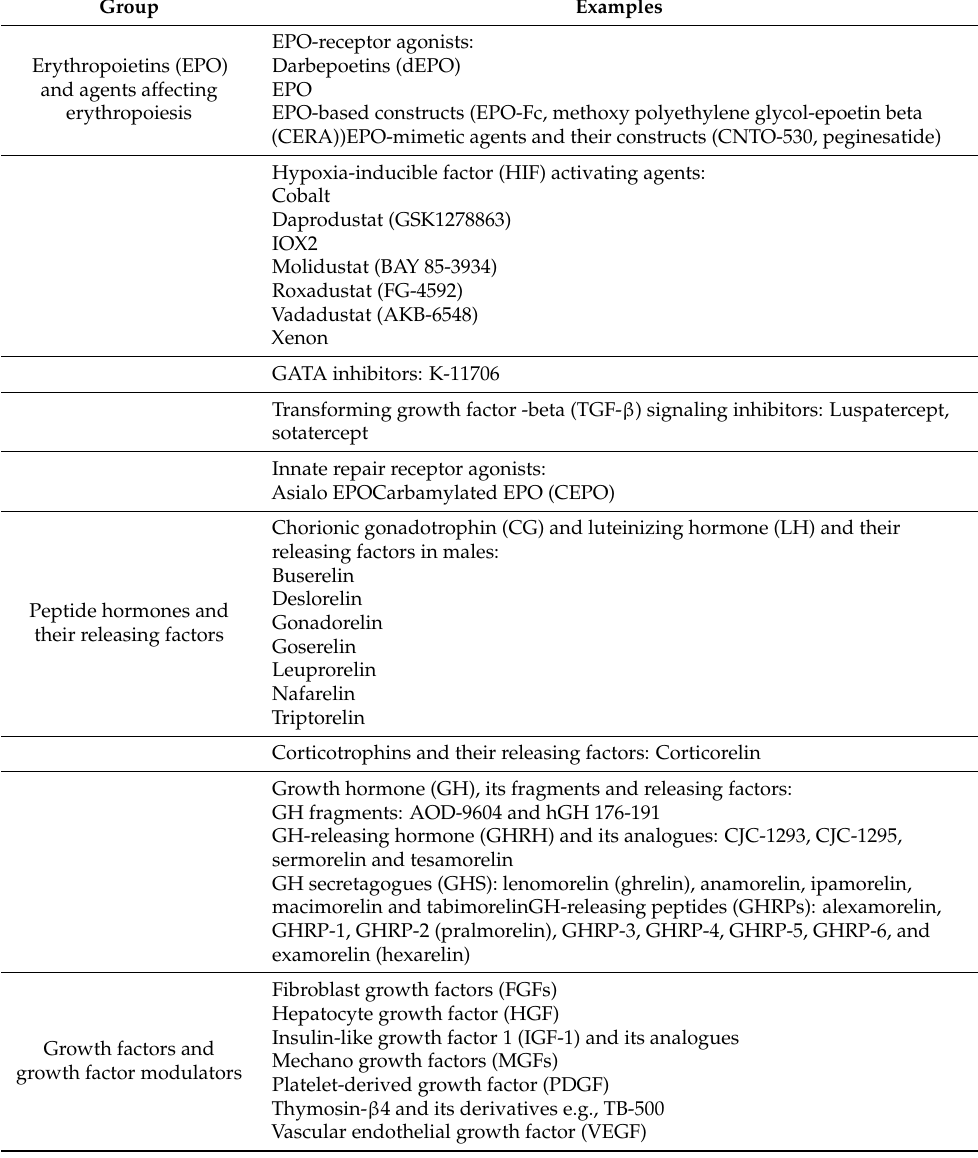
Table 5. List of prohibited peptides and proteins issued by World Anti-Doping Agency